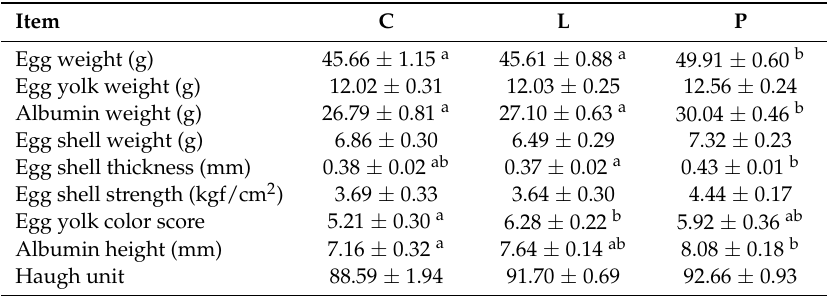
Table 7. Egg quality of laying hens at day 30 of the experiment ( n = 18).